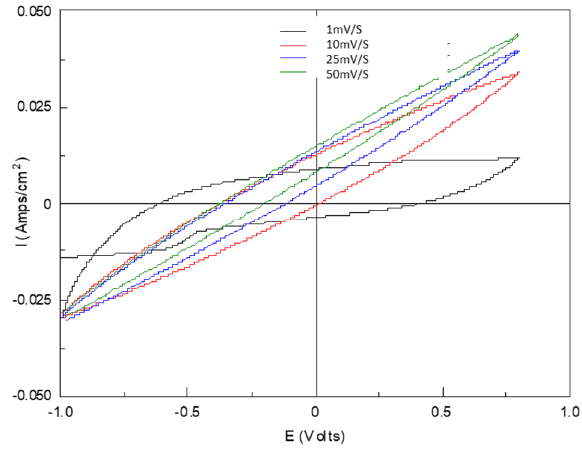
Figure 4. Cyclic voltammogram sweeps of material 1 (felt) (closed-circuit) using 1, 10, 25 and 50 mV/s scan rates. E (V) versus Ag/AgCl.